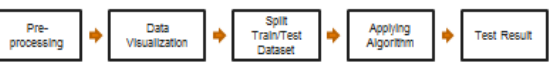
Fig.4.Steps involved in proposed